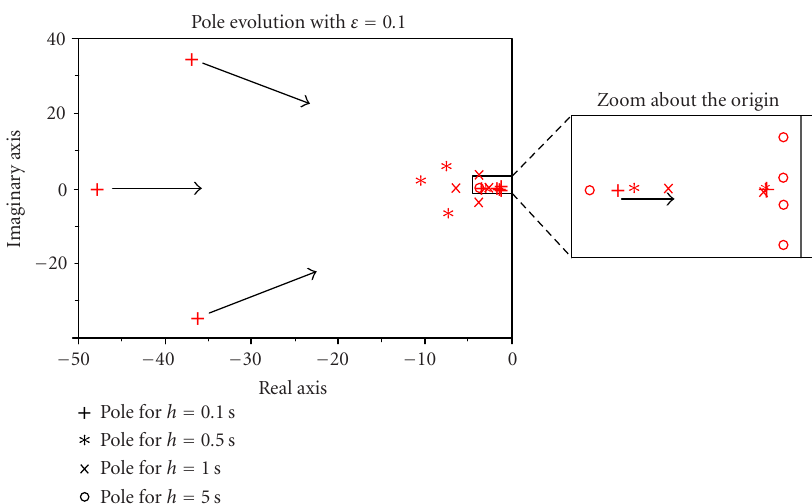
Figure 5.1. Third-order Pade’s approximation: the arrows show the pole motion as the delay h in- creases for ε = 0 . 1.